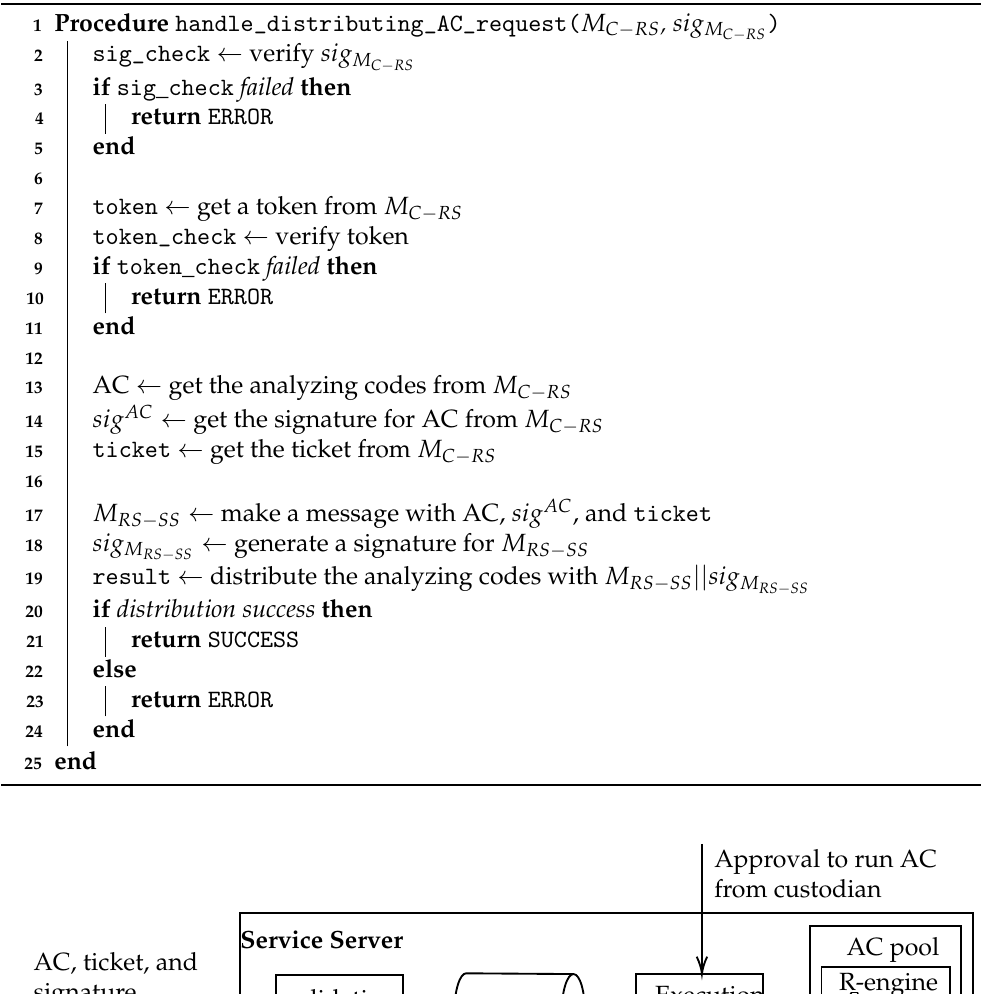
Algorithm 8: The AC distributing algorithm on the RS side